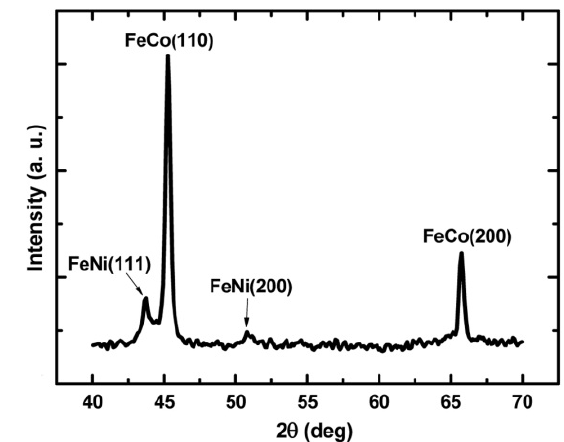
Fig. 3. XRD pattern of FeCoNi NWs with with length of 32  m